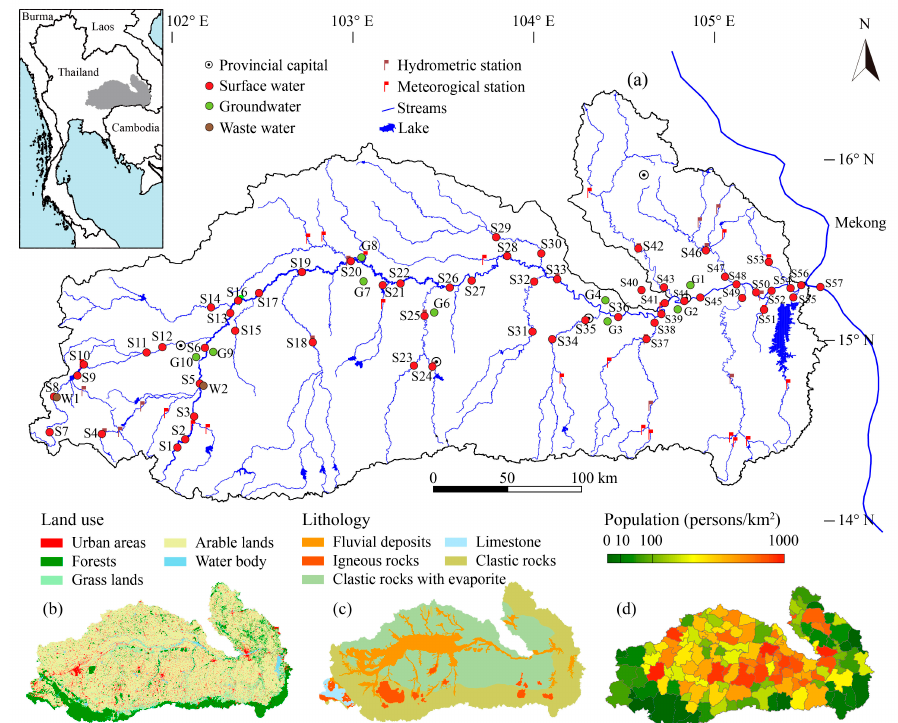
Figure 1. Maps of the Mun River Basin created by using ArcGIS software. ( a ) The hydrographic network with sampling sites and ( b ) land uses in the Mun river basin; ( c ) lithology of the Mun river basin; ( d ) density of population at district level (persons per square kilometer).